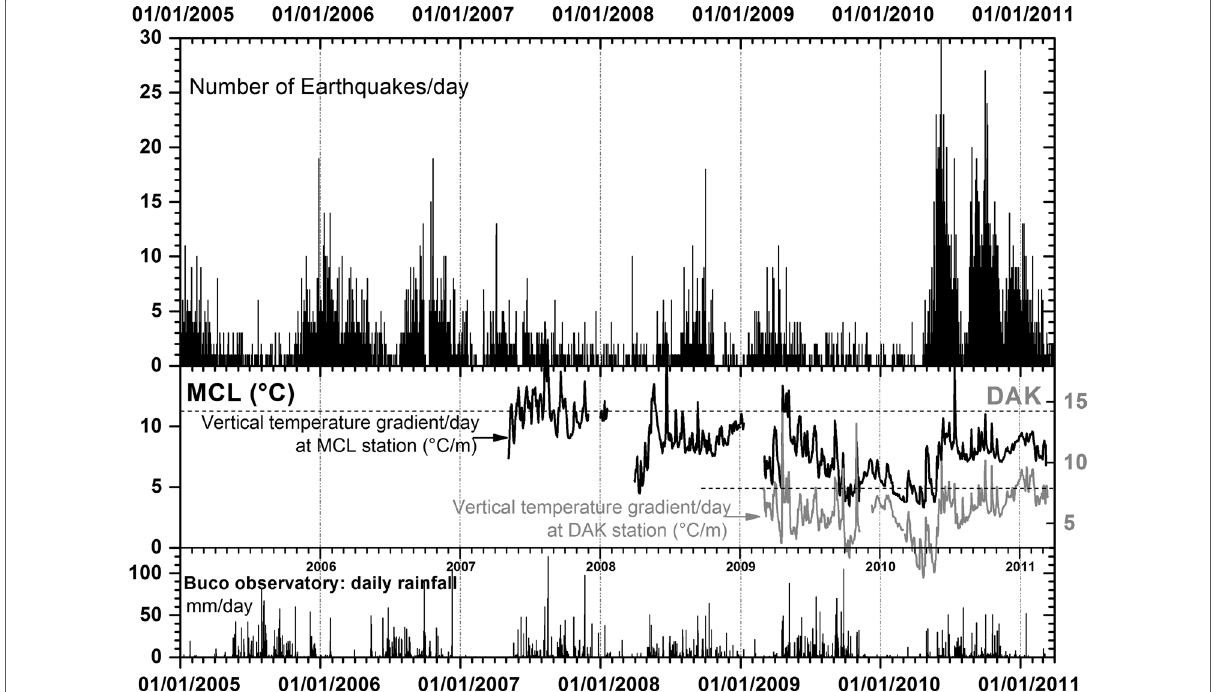
Fig. 4 Top: Daily number of volcanic earthquakes recorded by local Buco Observatory (PHIVOLCS personal communication) between January 2005 and March 2011. Middle: Normalized vertical gradient of ground temperature measured between 40 and 80 cm depth at MCL (black) and DAK (gray) stations. Bottom: Daily rainfall measured at Buco local observatory located at 8 km from Taal